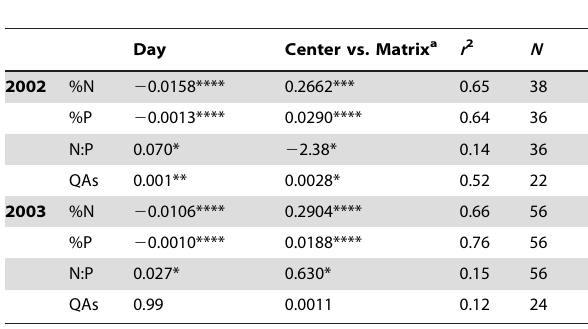
Table 2. Regression analyses of lupin leaf tissue nutrient and alkaloid content on date and